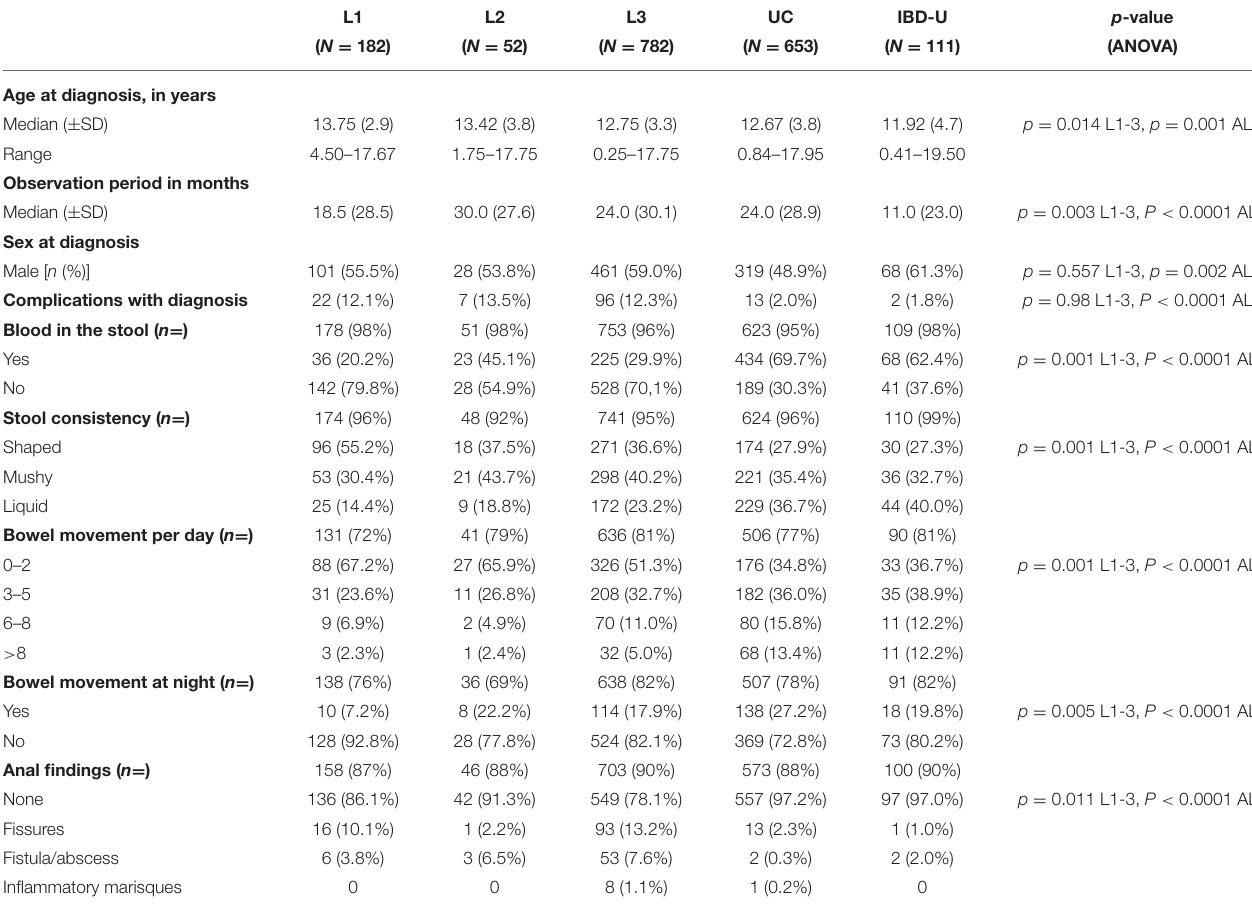
TABLE 1 | Basic characteristics of patients according to their disease.